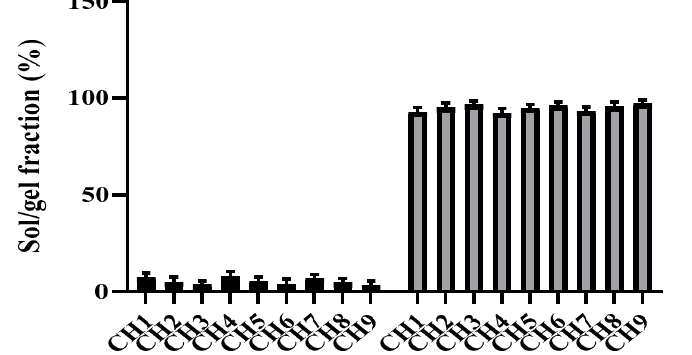
Figure 12. Sol–gel fraction % of BSG-co-poly (AA) hydrogels